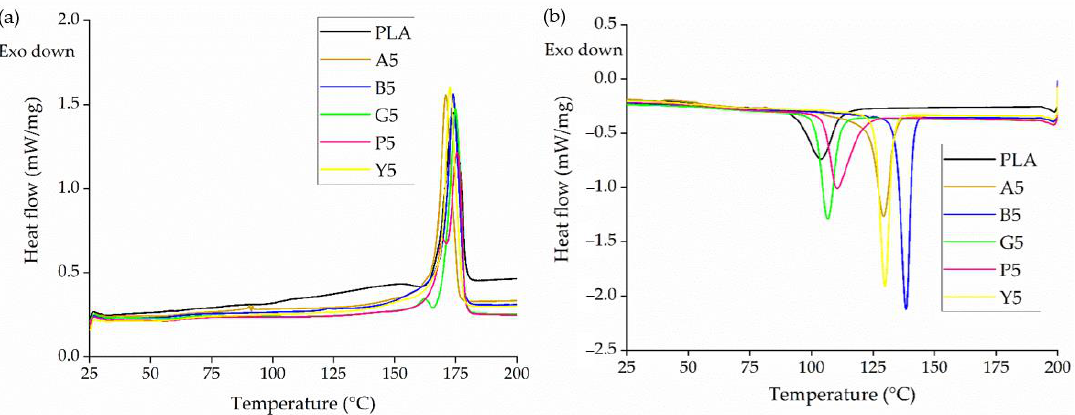
Figure 4. DSC thermograms of PLA and its master batches containing 5% ( w / w ) of each colorant during ( a ) the heating cycle and ( b ) the cooling cycle.